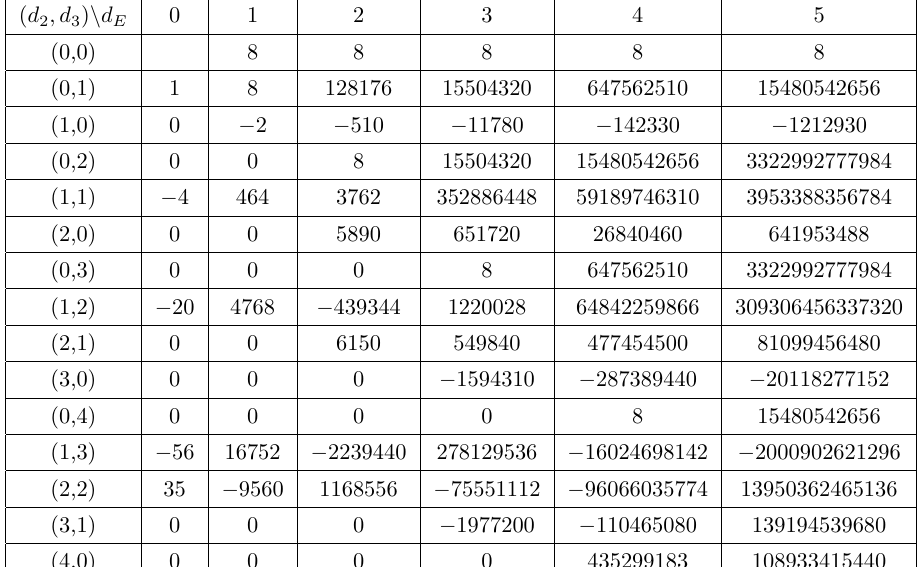
for the genus ( g ) = (0 , 1) L , g R ( d E ,d 2 ,d 3 )